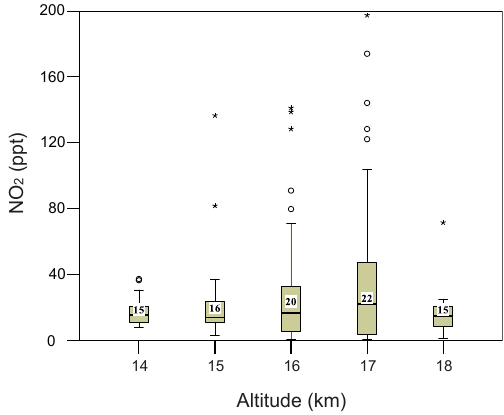
Figure 8. Box plot of CAM-Chem NO 2 estimates as a function of altitude during daylight over the eastern Pacific. The filled boxes display the minimum, first quartile (Q1), median (Q2), third quar- tile (Q3), and maximum values. The black line across the interior of the box represents the median (Q2) of NO 2 for the corresponding altitude. The bottom of the box is the first quartile (Q1) or the 25th percentile; the top of the box is the third quartile (Q3) or the 75th percentile. T bars extending from the boxes represent the largest and the smallest non-outlier values. Circles and stars are the outliers de- fined according to the interquartile range (IQR = Q3–Q1): circles are the “out values” or the NO 2 mixing ratios greater than 1.5 times the interquartile range, and stars are the “extreme values” or the NO 2 mixing ratios greater than 3 times the interquartile range. The numbers inside the box represent the average NO 2